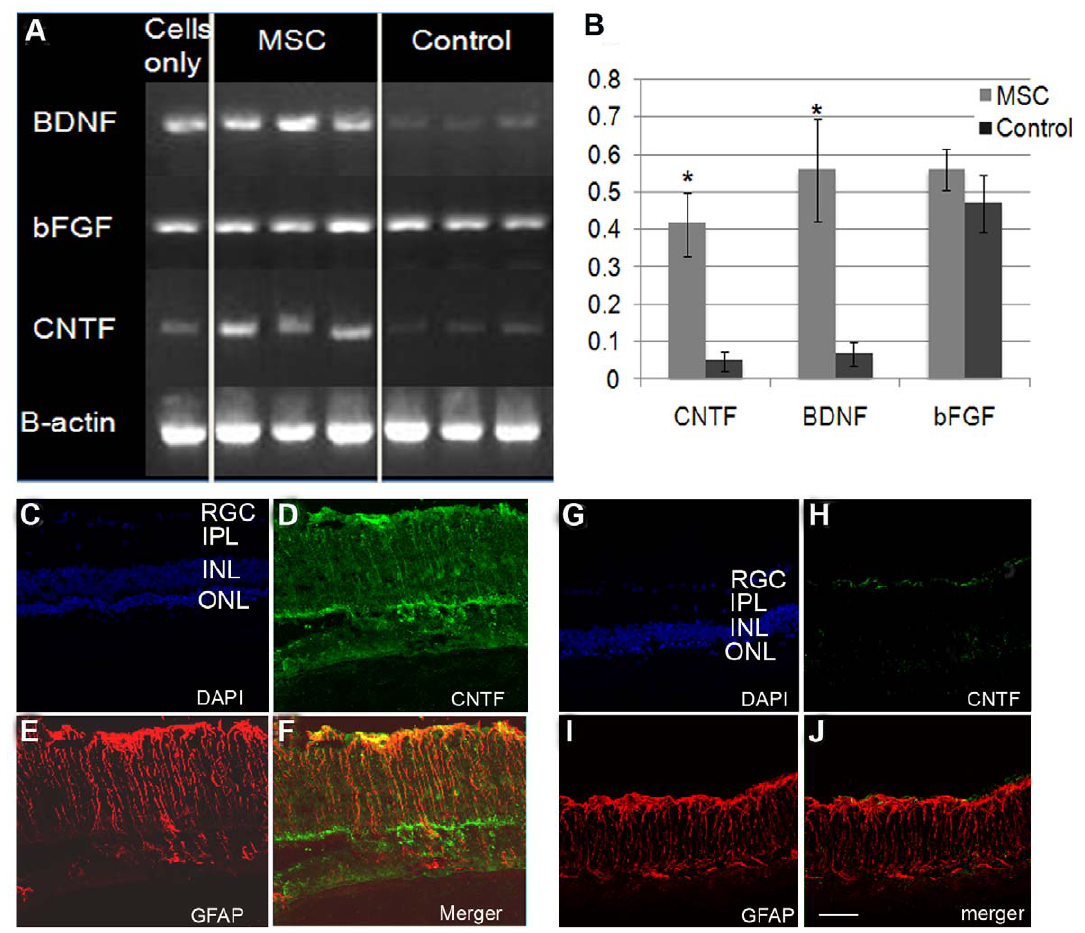
Figure 4. Upregulation of trophic factors. A. Semi-quantitative RT-PCR for CNTF, bFGF, BDNF and beta actin. Lane 1: RNA isolated from MSC prior to injection; Lane 2–4: RNA isolated from retinas treated with MSC; Lane 5–7: RNA isolated from non-treated control retinas. B. Densitometry analysis of CNTF, BDNF and bFGF in treated versus untreated samples. Beta actin was used to normalize the data for comparison. Level of CNTF and BDNF in the treated retinas were significantly higher than non-treated controls (p , 0.05), while the level of bFGF in MSC treated retina did not increase significantly. C–J: confocal images of retinal sections double stained with antibodies to CNTF (green) and GFAP (red), counterstained with DAPI (blue in C and G) from MSC treated and controls. Strong CNTF staining in MSC treated retina (D) compared with untreated control (H); E&I: retinal sections stained with GFAP (red) showing upregulation of GFAP in Mu¨ller glia in both MSC treated and untreated control; F&J: merged images showing colocalization of CNTF and GFAP in MSC treated retina (F), which was not observed in untreated control (J) (Scale bar equals 50 m m).